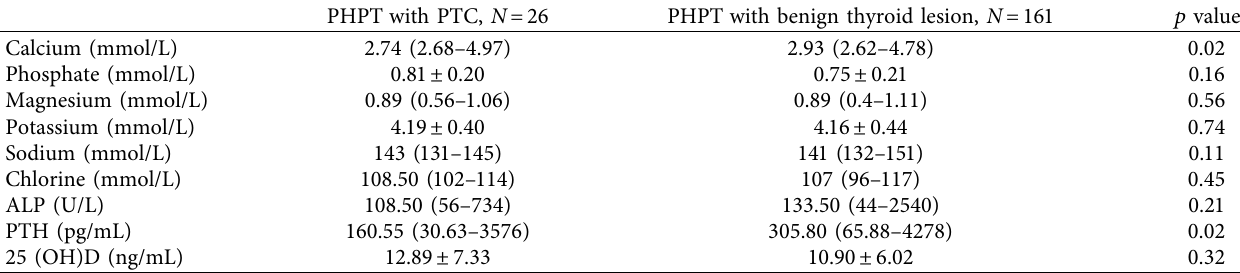
Table 2: Comparison of serum laboratory markers between PHPT patients with PTC or benign thyroid lesion.